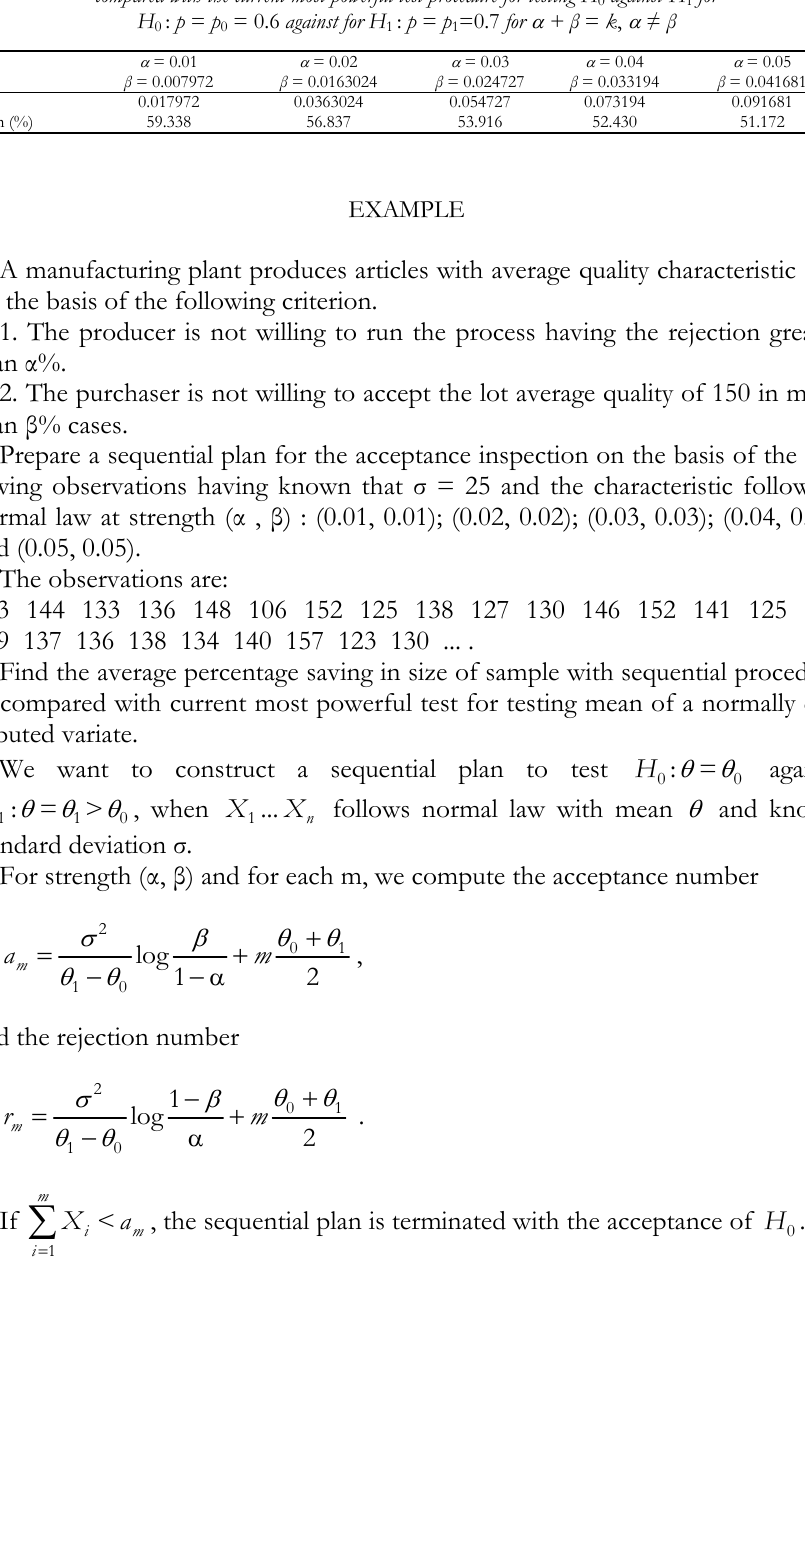
Average percentage saving of size of sample with the generalized modified SPRT analysis compared with the current most powerful test procedure for testing H 0 against H 1